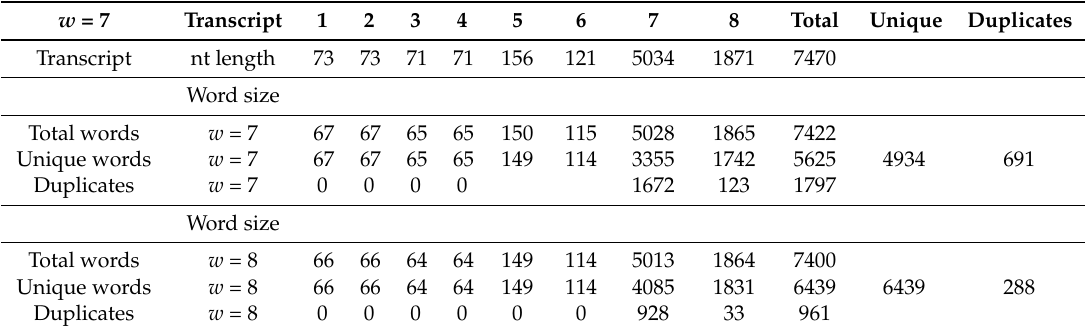
Table 3. Construction of transcriptome cloud for word size of 7 and